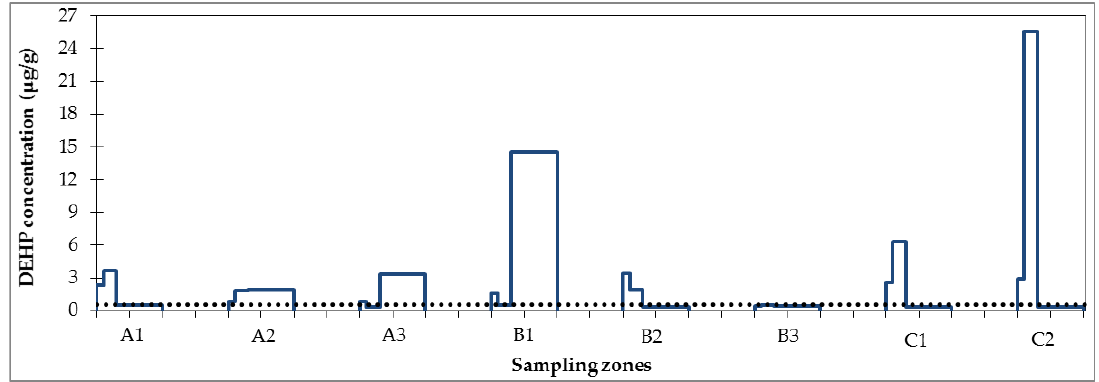
scale from left to right. The dotted line represents the concentration measured in the initial soil